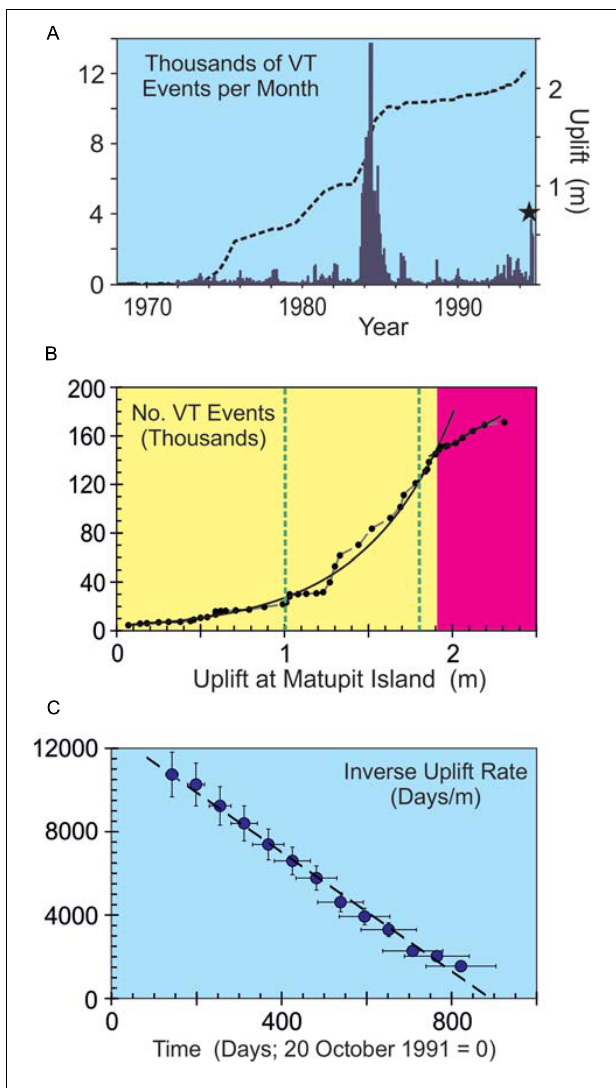
FIGURE 8 | (A) VT event rate ( columns ) and uplift rate ( gradient of dashed curve ) both fluctuated unevenly with time during the 23-year approach to Rabaul’s eruption in 1994. (B) The change in number of VT events with uplift shows the evolution from accelerating quasi-elastic ( yellow ) to linear inelastic ( magenta ) behavior (a normalized version is shown in Figure 4 ). The dashed green lines show conditions corresponding to the 1983–1985 crisis when rates reached their peak values (see A ). Note how the expected VT-uplift trends persist in spite of significant variations with time in rates of seismicity and ground movement. (C) The inverse mean rate of uplift decreased linearly with time during 1992–1994. The best-fit trend ( dashed ) is [Inverse Mean Rate of Uplift] = 12784–14.38 t ( r 2 = 0.99) for inverse-rates in days m - 1 and time t in days; the trend corresponds to a hyperbolic increase in the mean rate of uplift. The contemporaneous inverse VT rates showed a less clearly defined trend (Robertson and Kilburn,